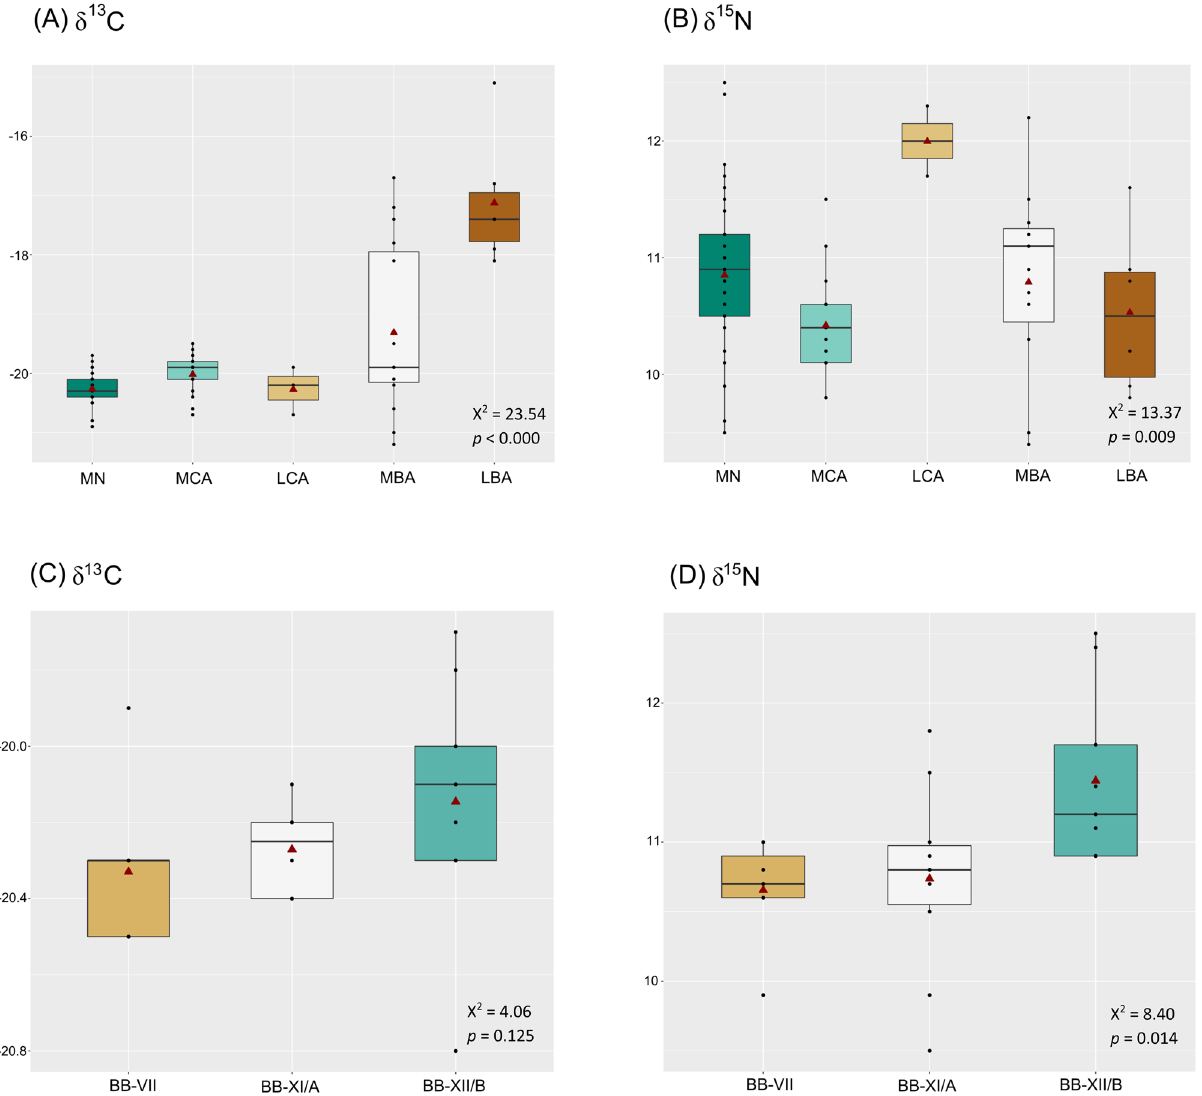
Figure 5. Boxplot showing δ 13 C and δ 15 N values for human samples by period (N = 74) ( A , B ) and by Middle Neolithic sites (N = 26) ( C , D ). Samples only include individuals ≥ 6 years old (see text for explanation). Red triangles show the means, middle horizontal lines represent the medians. Human isotopic values from Middle and Late Bronze Age sites were previously published in 15 . Middle Neolithic (MN, n = 33); Middle Copper Age (MCA, n = 17); Late Copper Age (LCA, n = 3); Middle Bronze Age (MBA, n = 15); Late Bronze Age (LBA, n = 6). Sites: Bükkábrány-Bánya VII (BB-VII, n = 7); Bükkábrány-Bánya XI/A (BB-XI/A, n = 10); Bükkábrány-Bánya XII/B (BB-XII/B, n =